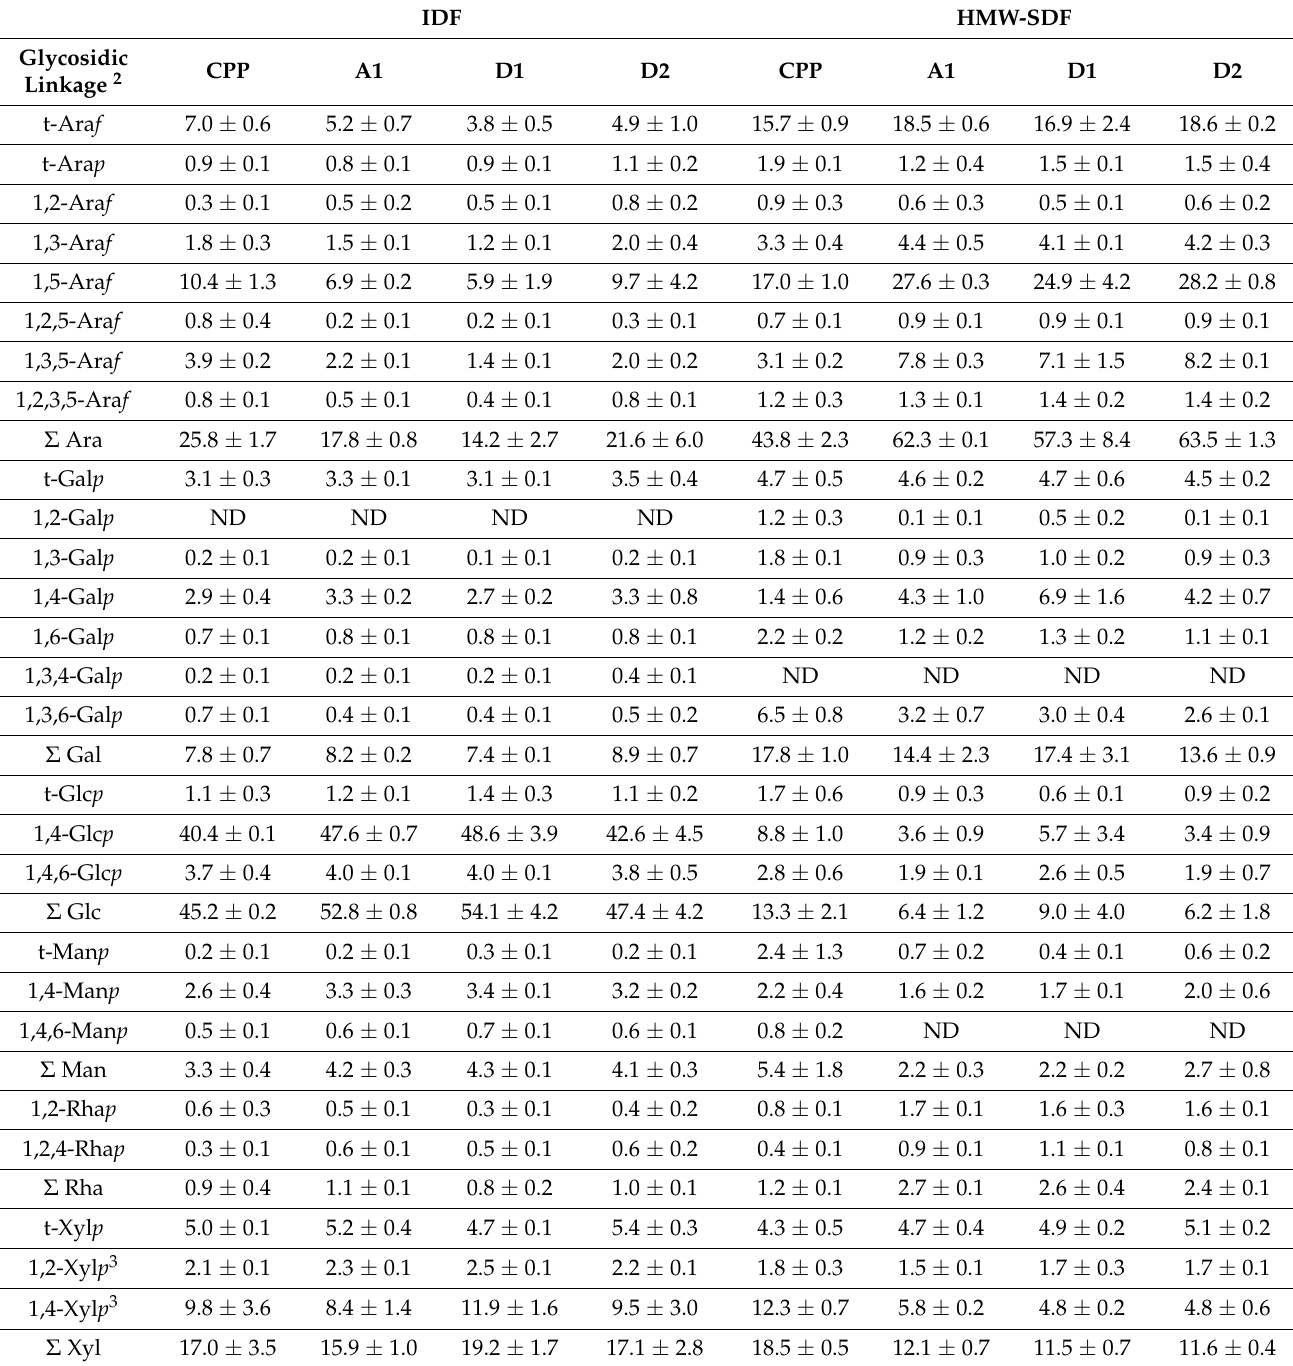
Table 3. Partially methylated alditol acetates (PMAA) from insoluble dietary fiber (IDF) and high molecular weight soluble dietary fiber (HMW-SDF) fractions isolated from chokeberry pomace powder (CPP) before and after extrusion processing 1 (mol%, range/2, n = 2).